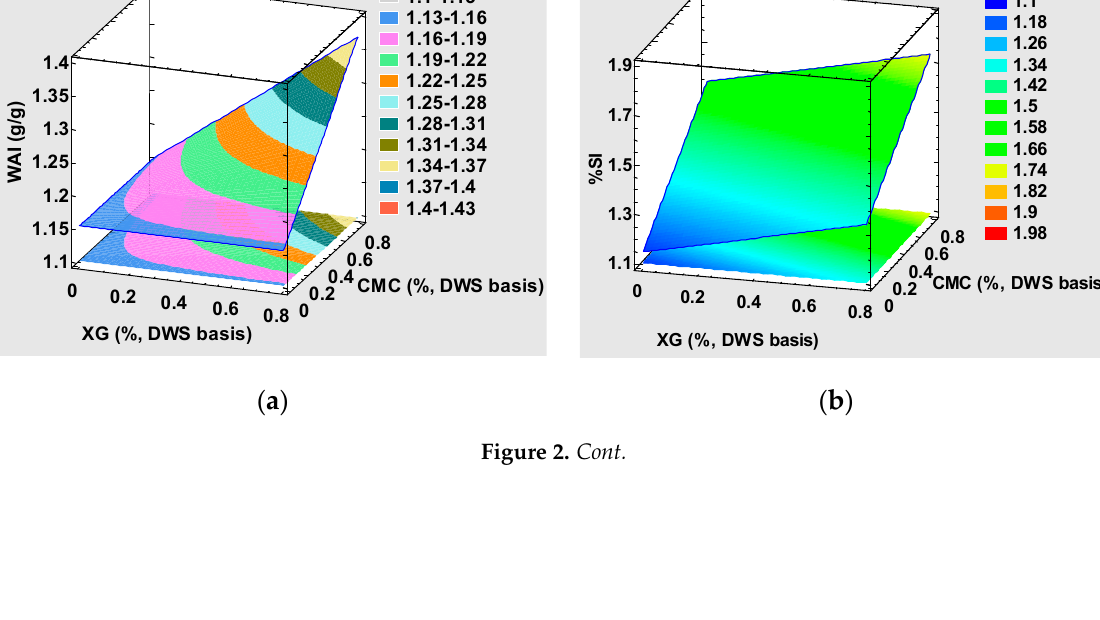
( f ) Figure 2. ( a – f ). Effect of the CMC, GX, and LBG levels on water absorption index (WAI), the swelling index (%SI), cooking loss (%CL), and fiber loss (%FL). CMC, carboximethylcelullose; XG, xanthan gum; LBG, locust bean gum. 4. Conclusions The results from this manuscript address the improved nutritional value and fair techno-functional properties obtained with fresh tiger nut-based tagliatelle when XG was employed as a structural agent. Marked fiber and fat enhancement (rich in oleic and lino- leic acids) contents, along with mineral enrichment, may be attained in tiger nut pasta. XG at 0.8% concentration considerably improved the textural characteristics and, accordingly, fresh pasta’s cooking behavior. This means that a better structure with a continuous pro- tein matrix to entrap starch granules is feasible.